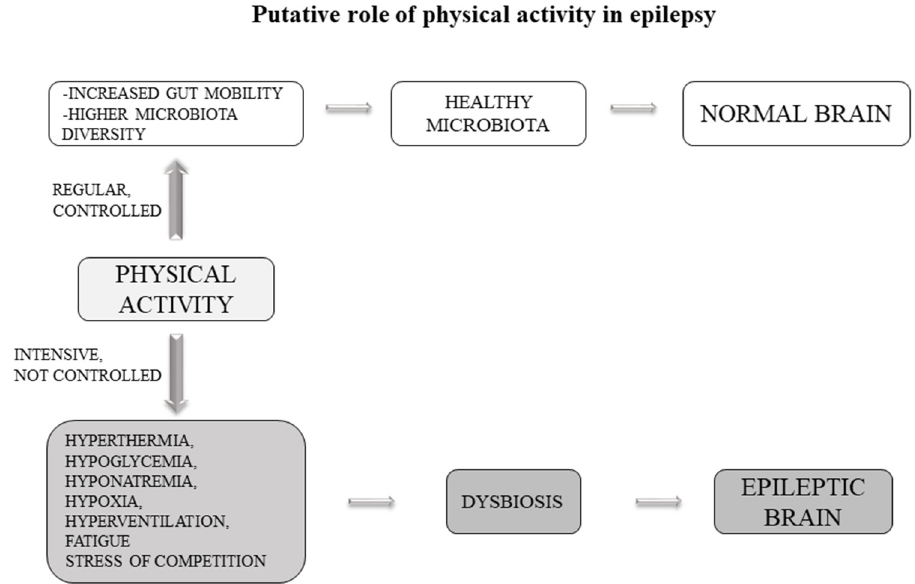
Figure 2. Putative role of physical activity in epilepsy. Physical activity can induce or reduce epileptic seizures. In case of intense (or inadequate) physical activity in predisposed subjects, some side effects (such as stress, hyperventilation, fatigue, hypoglycemia, etc.) can alter the gut microbiota towards a condition of dysbiosis and favor epileptic seizures. Adequate and regular physical activity can instead promote gut mobility and create higher microbiota diversity, leading to a reduction or inhibition of seizures.